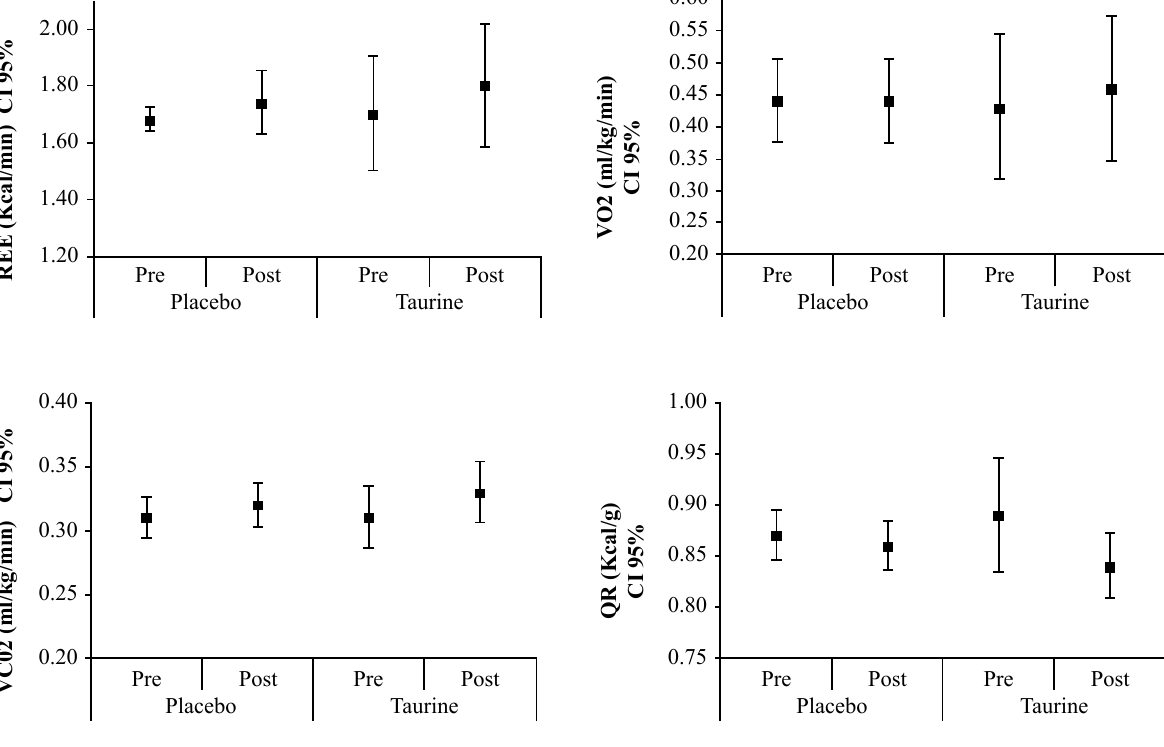
Figure 2. Evaluation of REE, VO